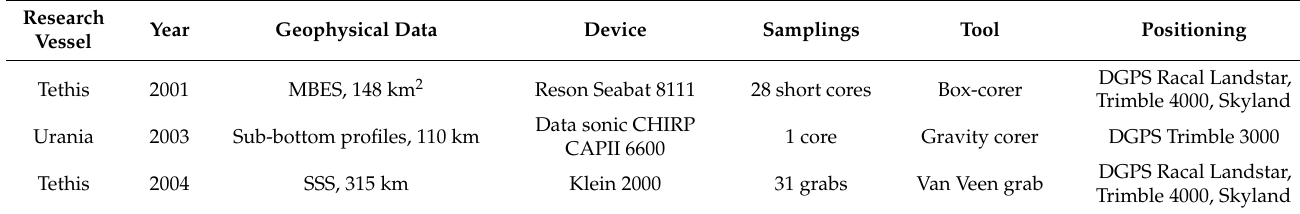
Table 1. Summary of data acquisition